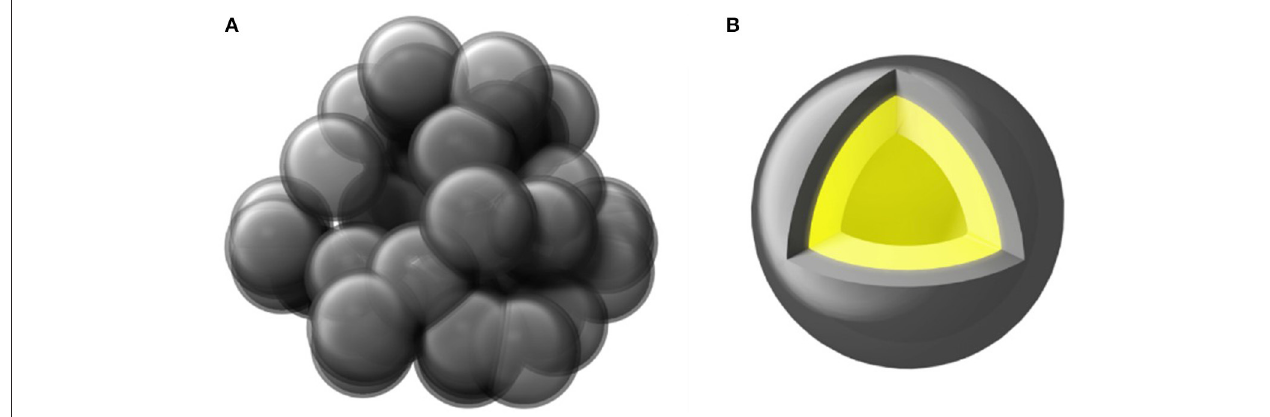
FIGURE 1 | The schematic diagrams of (A) PGBs and (B) PGBs@S.